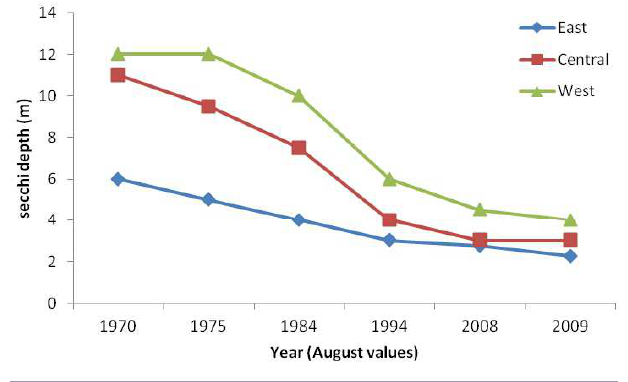
Fig. 3. Decline of seawater transparency in the eastern, central, and western basins of Izmit